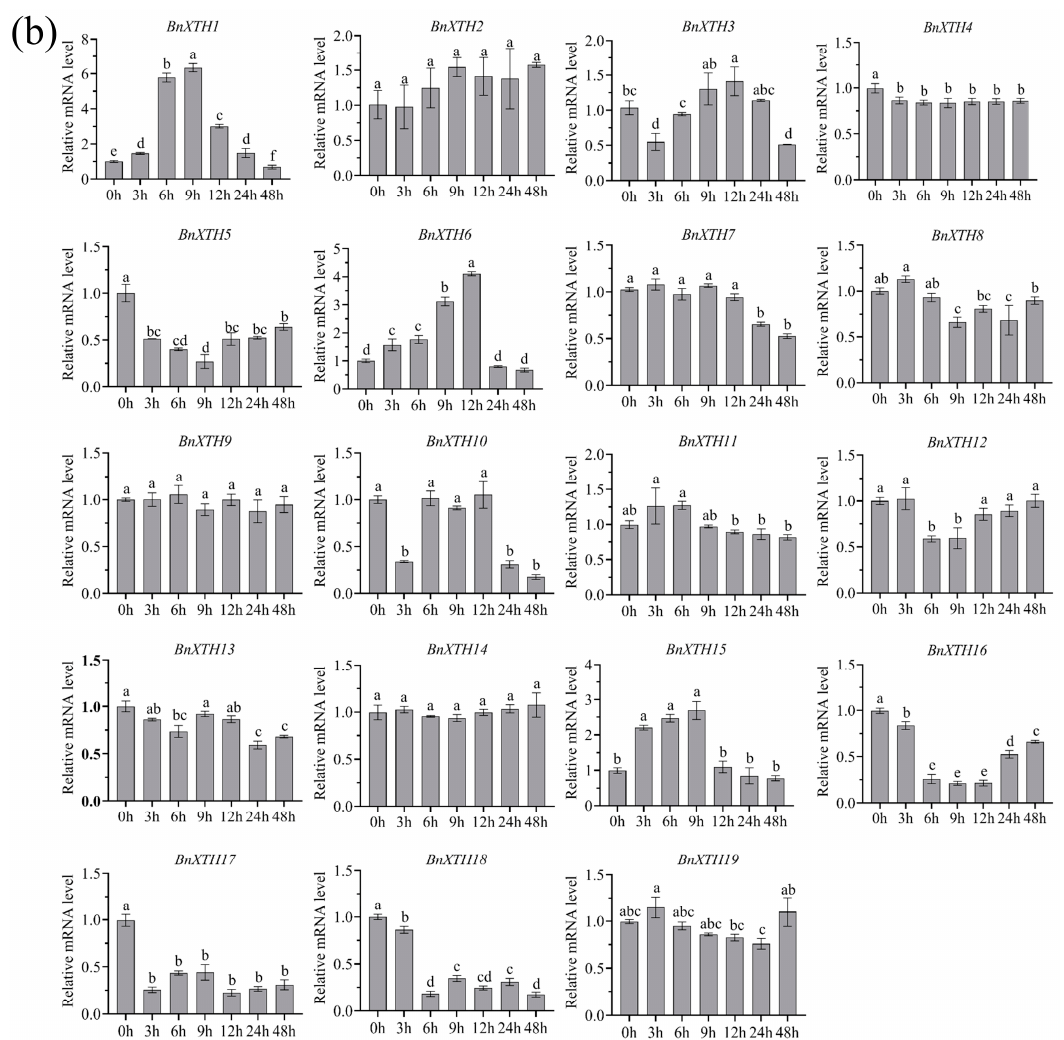
Figure 6. Expression analysis of the BnXTH genes under Cd stress. ( a ) Heat map of BnXTH -family genes expression level. ( b ) Expression of 19 BnXTH genes by qRT-PCR. Ramie seedlings were treated with Cd, and the root samples were collected at 0, 3, 6, 9, 12, 24, and 48 h after treatment. Boehmeria nivea actin ( BnActin ) was used as the internal control. Data are presented as means ± SD ( n = 3). Statistical significance was determined using an LSD test. Different letters indicate significant differences at p ≤